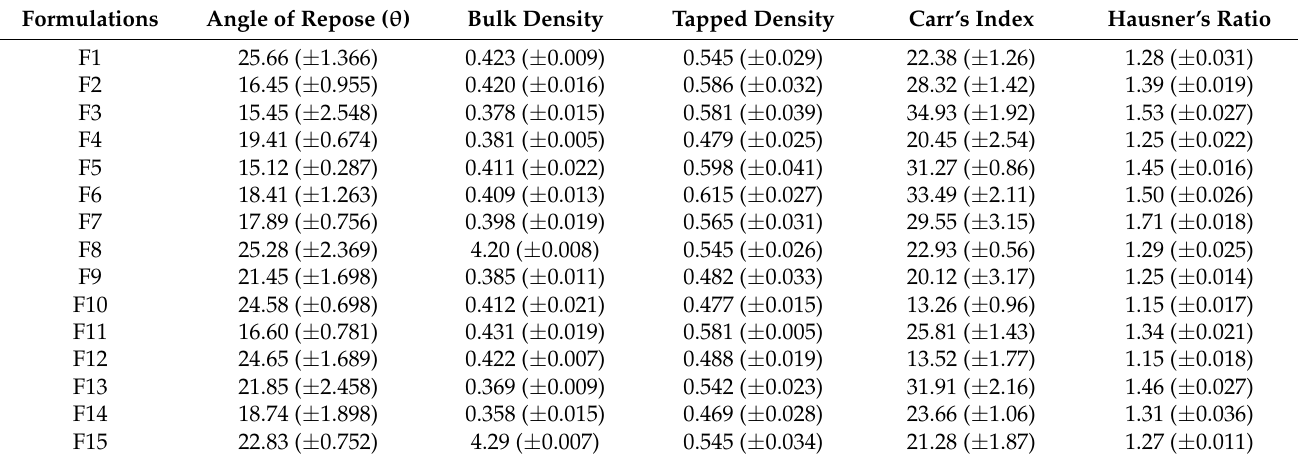
Table 3. Pre-compression characterization of the powder blend of